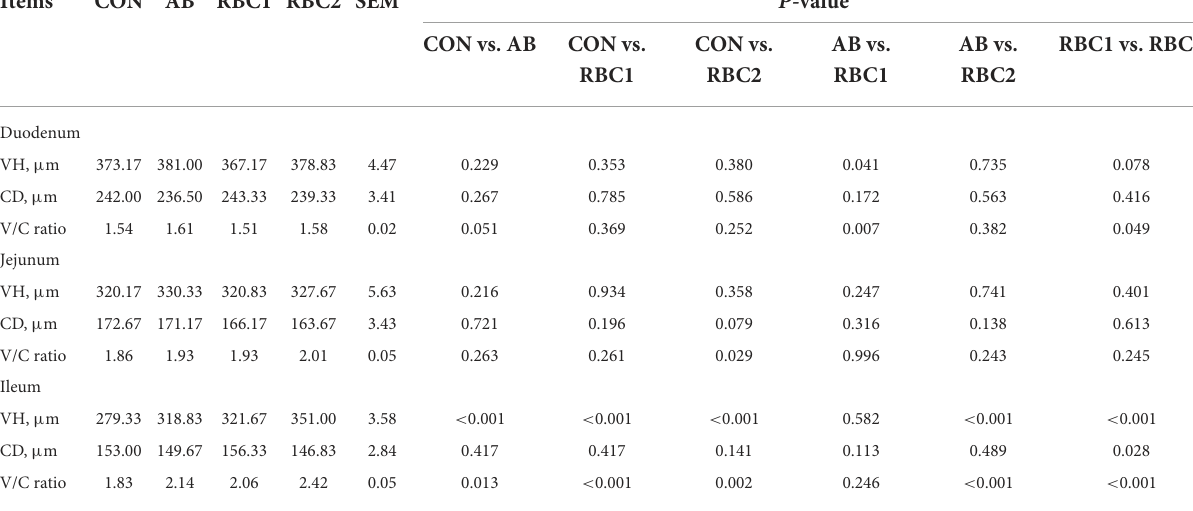
TABLE 5 Effect of dietary RBC and AB supplementation on the intestinal morphology of weaning piglets.